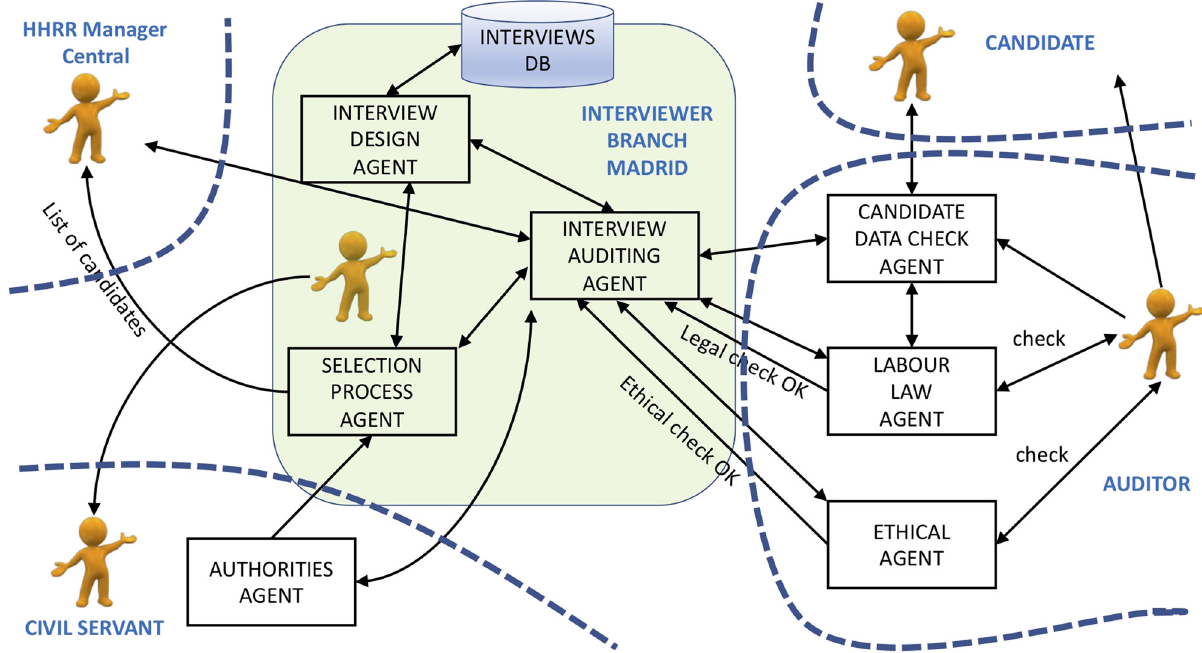
Figure 1: Multi - agent system architecture for HR